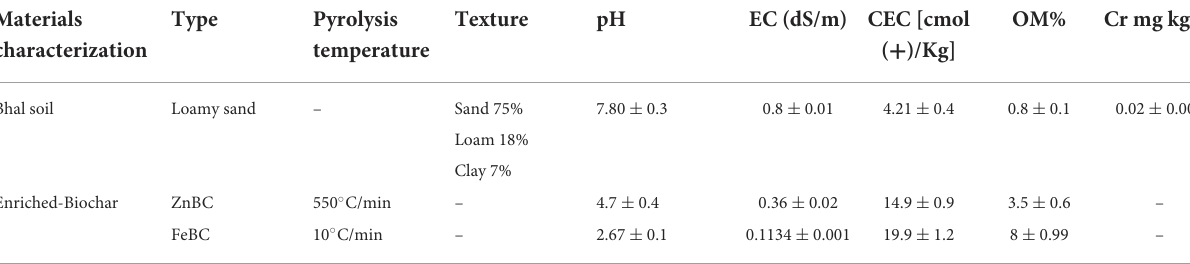
TABLE 1 Soil and biochar physicochemical properties (Mean ±